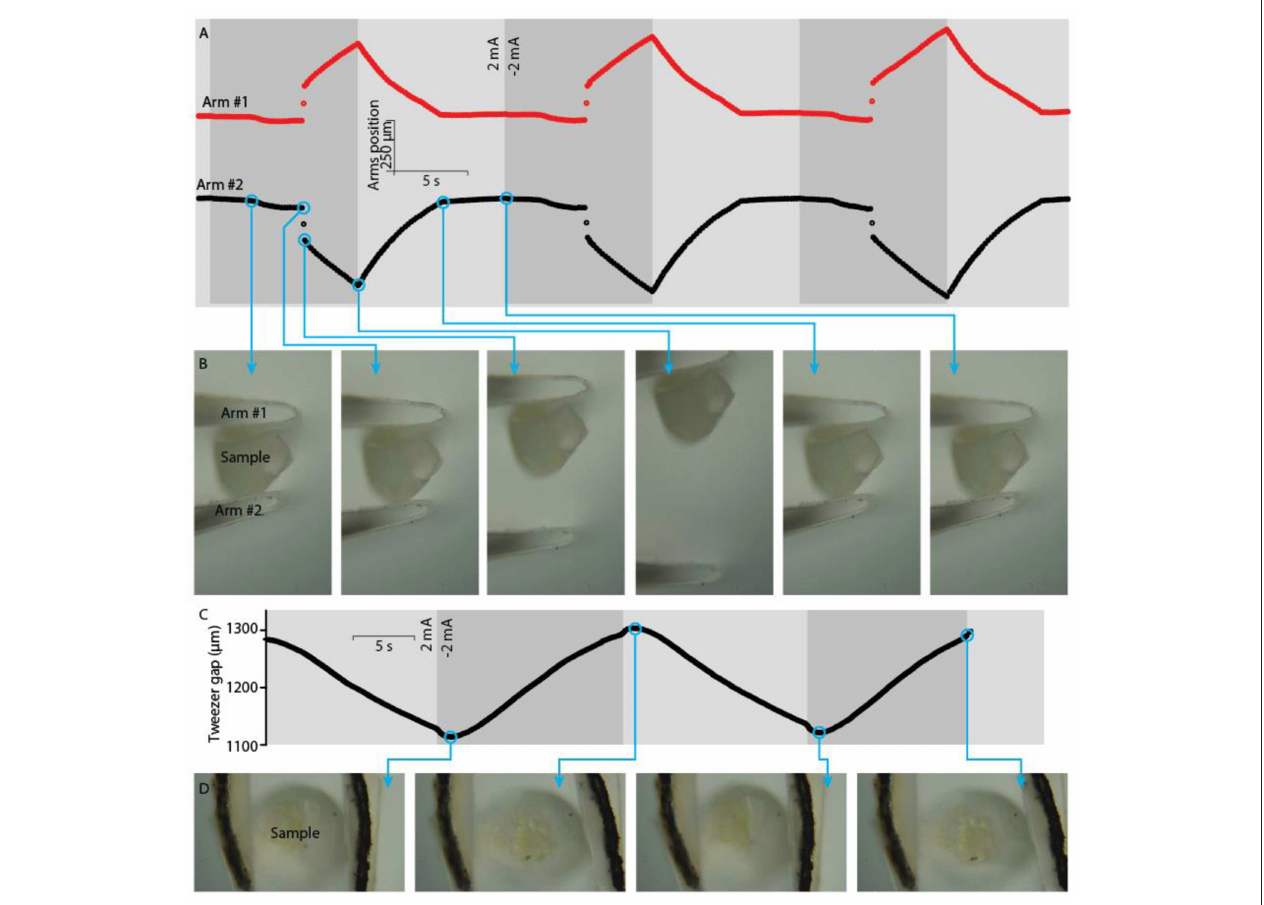
FIGURE 10 | Manipulation of a soft biological sample, a capelin egg. (A) Positions of tweezer arm tips while repetitive clamping-releasing of a capelin egg, and (B) optical micrographs corresponding to the indicated time steps. (C) Position of tweezer arms while squeezing a capelin egg, and (D) the corresponding optical micrographs.